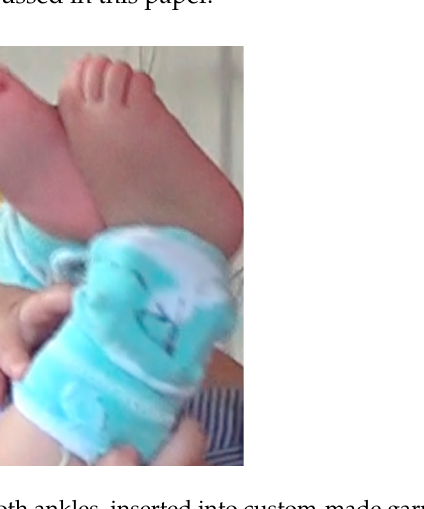
Figure 1. Infant wearing sensors on both ankles, inserted into custom-made garments with internal pockets to hold sensors.